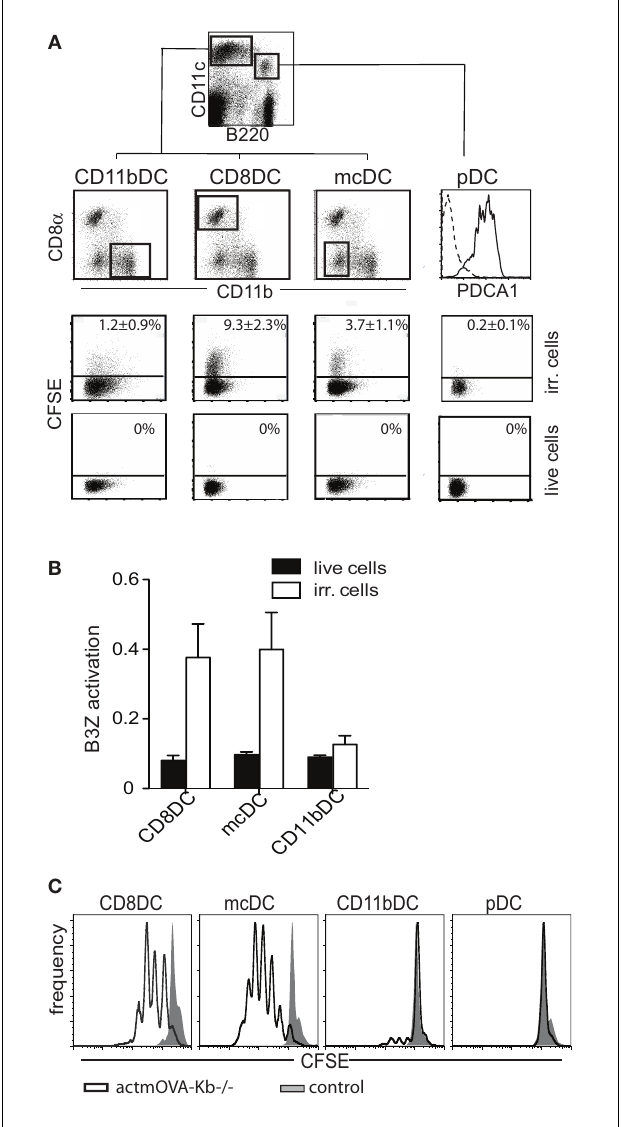
FIGURE 1 | Differential uptake of dying cells and subsequent cross-priming by splenic DC populations. (A) Live or irradiated CFSE-labeled OVA-expressing splenocytes were injected (i.v.) into mice. After 2h uptake CFSE-labeled material was analyzed in indicated splenic DC subsets. (B) Mice were i.v. injected with irradiated OVA-expressing K b -deficient splenocytes (Ehst et al., 2003). Cross-presentation of H-2K b restricted OVA 257–264 was assessed by activation of an OVA 257–264 -specificT cell hybridoma, B3Z (Karttunen et al., 1992). (C) Characteristic cross-priming – as determined by CFSE dilution – of OVA 257–264 -specific CD8 + T cells by purified DCs upon in vitro culture with apoptotic OVA-expressing K b -deficient